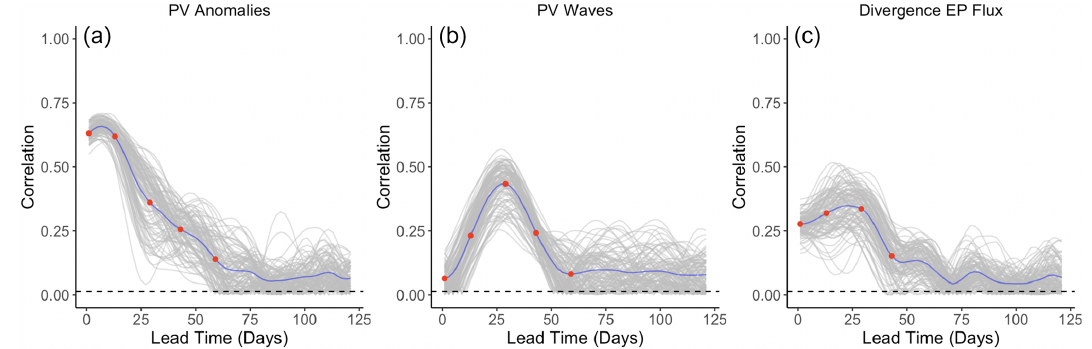
Figure 5. Maximum correlation as a function of the lead time for PV anomalies (a) , PV waves (b) , and eddy heat flux (c) . Each of the gray curves is obtained by randomly selecting 30 years to which the sPCA algorithm is applied for each individual lead time τ = 1 ,..., 126(d) to predict the index I . Correlation is then computed using the 10 remaining years. Random winter selection and splitting is repeated 100 times to obtain the displayed set of curves. The blue curve represents the mean of all gray curves. Correlation is significant at a 5% confidence level if fewer than five curves drop below the upper bound of the estimated confidence interval under the null hypothesis H 0 : corr {(cid:104) X(t 1 : (N − τ + 1 ) ),P τ (cid:105) ,I(t τ : N ) } = 0 denoted by the dashed black line. Red points represent the time steps − 6h and − 14, − 30, − 44, and − 60d, whose patterns can be found in Appendix